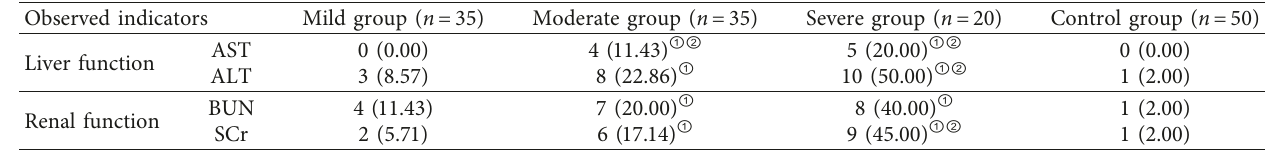
Table 4: Comparison of abnormal liver and kidney function rates among groups ( n